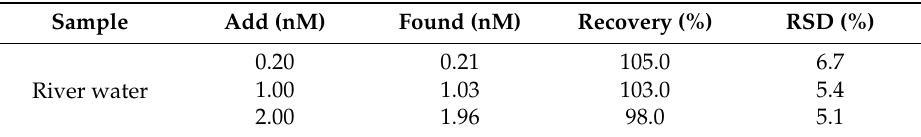
Table 3. The analysis of Ag + in the real water samples.